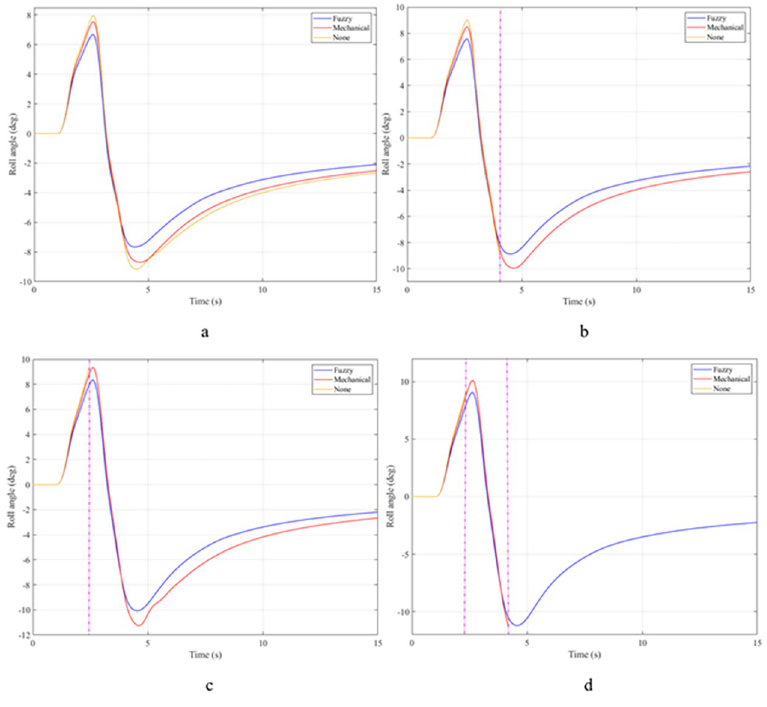
Fig 22. Roll angle.